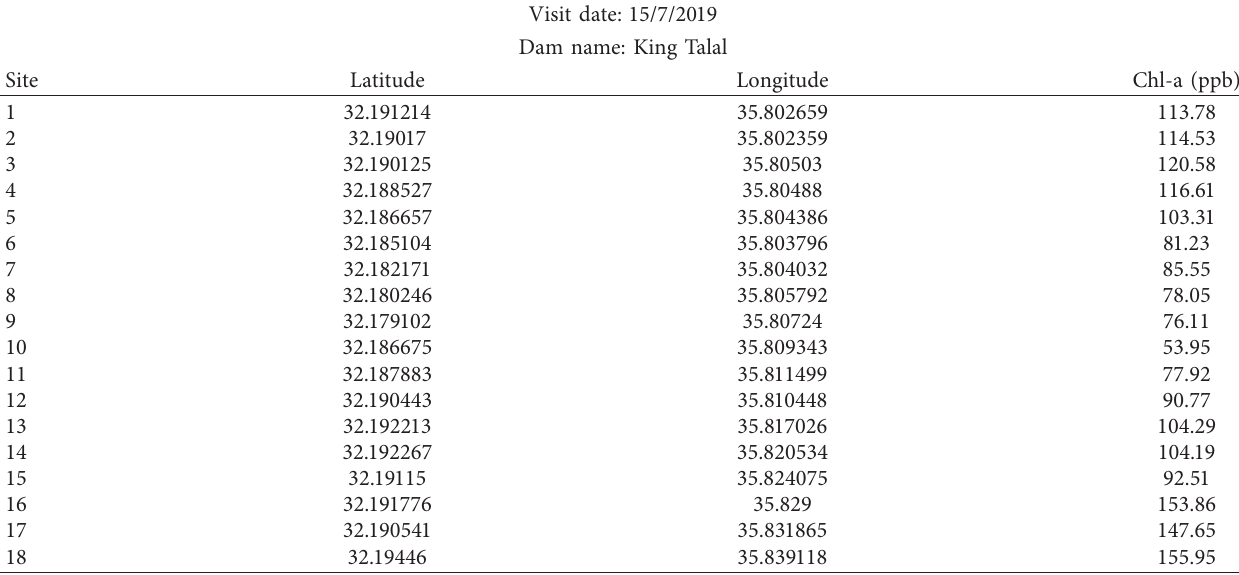
Table 1: Chl-a concentration and corresponding sampling points’ coordinates of samples collected from KTD.